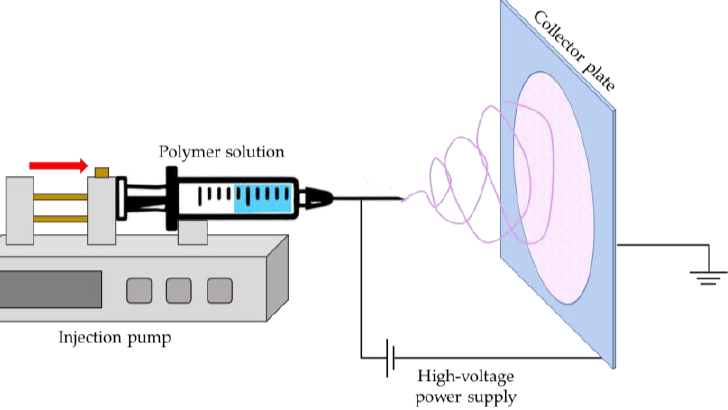
Figure 10. Schematization of the production of nanofibers with the electrospinning technique.